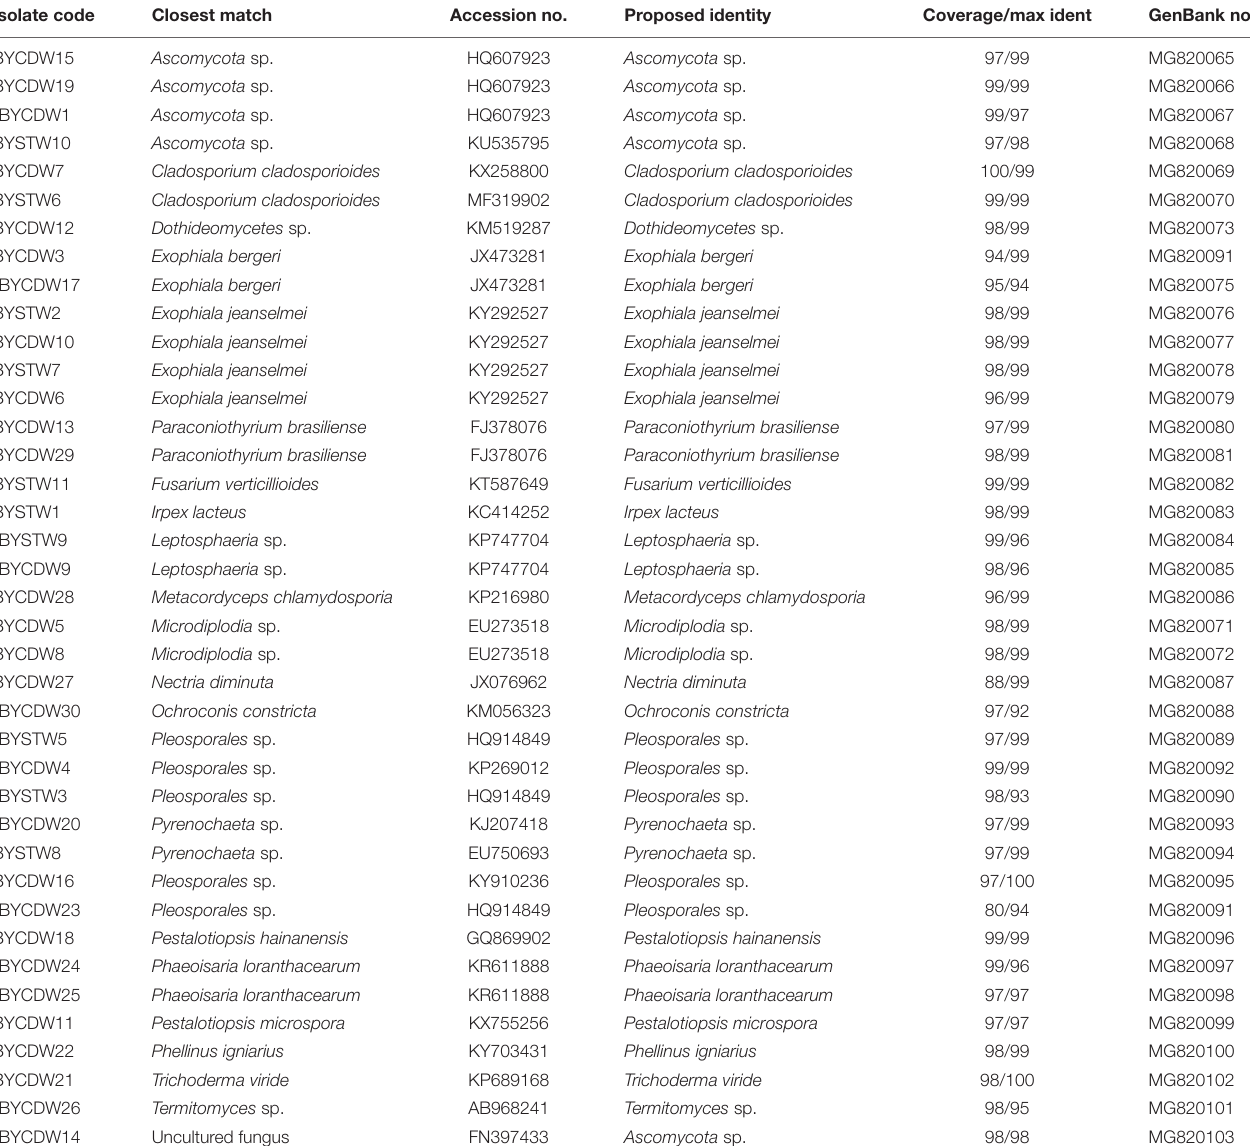
TABLE 1 | Phylogenetic analysis of cultivable fungi associated with O. formosanus. Isolate